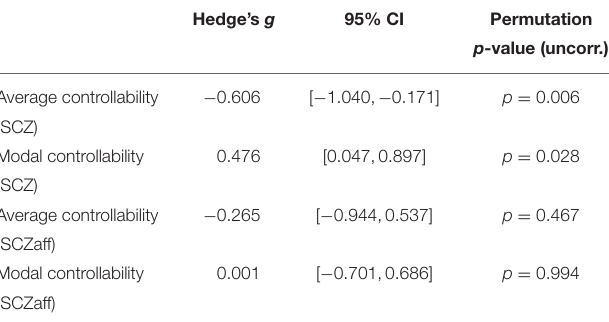
TABLE 4 | Permutation test statistics for the SCZaff group (sample size n = 9). Hedge’s g 95% CI Permutation p -value